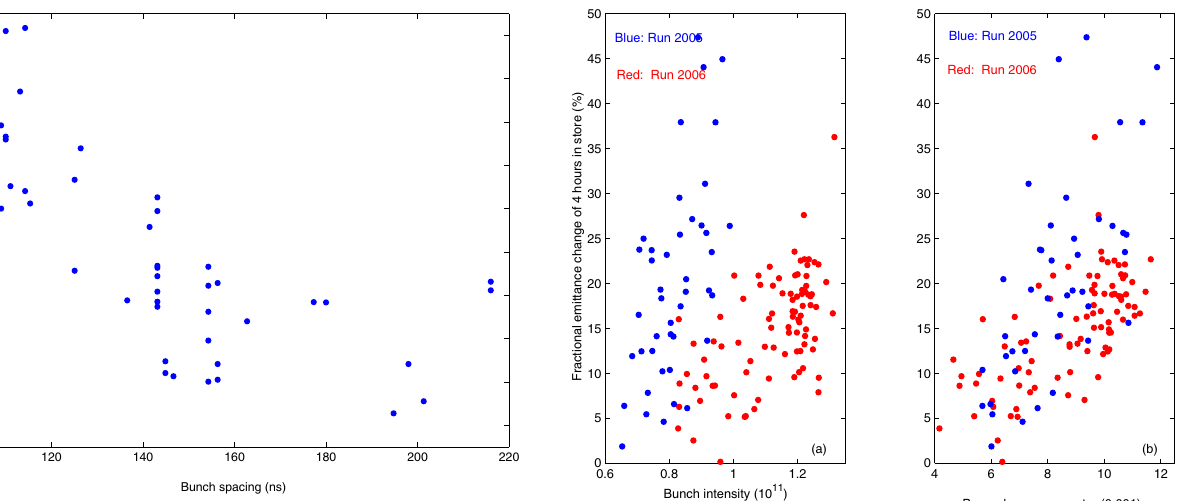
FIG. 6. (Color) Beam emittance at the early store versus the average bunch spacing. The data are from the latest 44 physics fills in run 2005, where the number of bunches injected into RHIC was gradually increased from 55 to 110. The bunch intensity varied between 0 : 61 (cid:1) 10 11 and 0 : 91 (cid:1) 10 11 protons, not